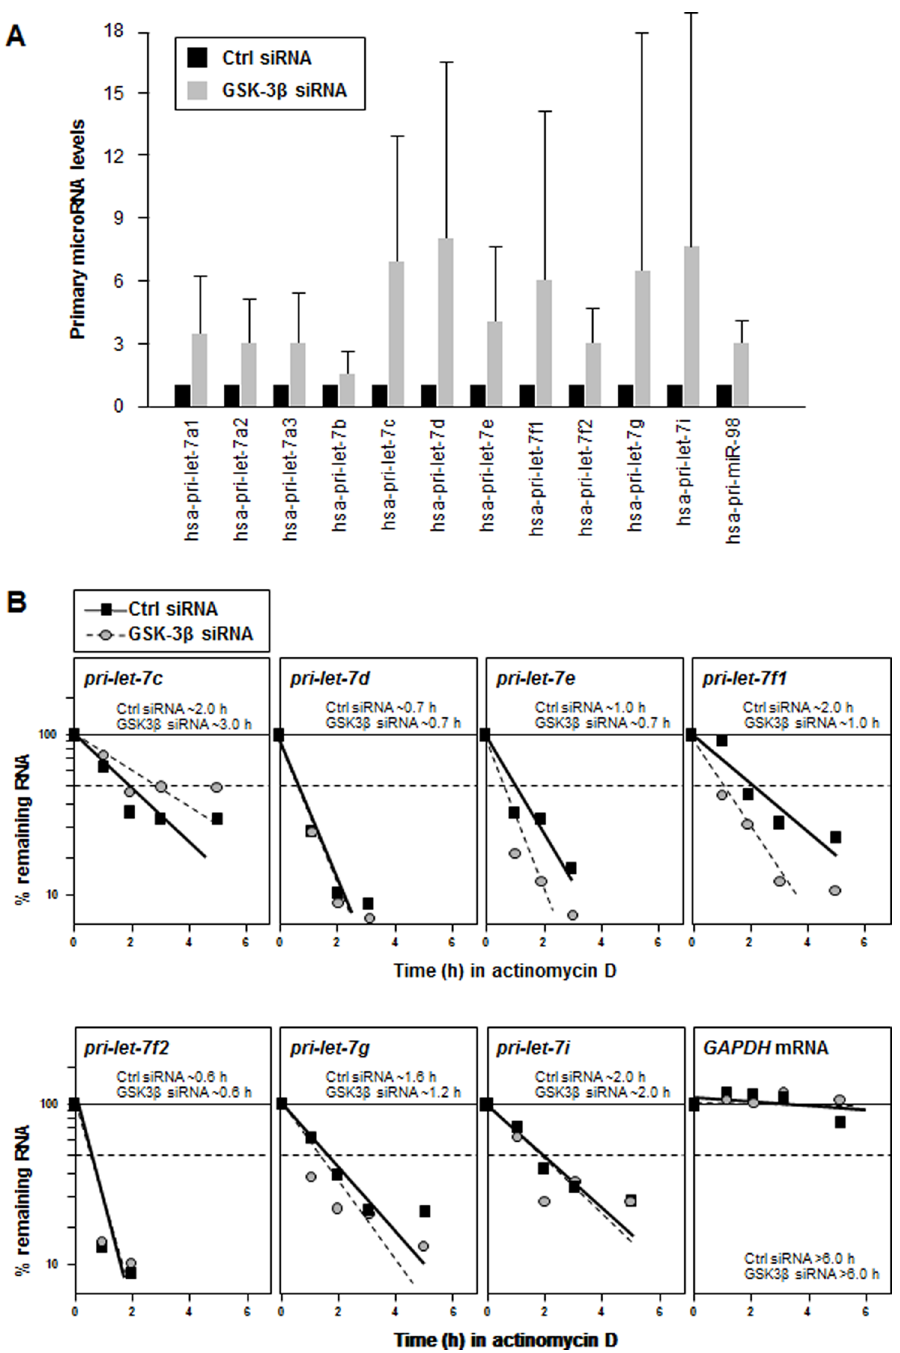
Figure 5. Pri-let-7 levels increase by GSK-3 b silencing mainly via transcriptional upregulation. ( A ) Forty-eight hours after transfecting BG- 1 cells with 100 nM Ctrl siRNA or GSK-3 b siRNA, total RNA was collected and pri-let-7 levels were quantified by RT-qPCR and normalized to 18S rRNA. ( B ) Forty-eight hours after BG-1 cells were transfected as in (A), actinomycin D was added and RNA was collected at the times indicated for RT-qPCR analysis of the levels of pri-let-7 transcripts and GAPDH mRNAs. After normalizing to 18S rRNA levels, the half-life of each RNA was calculated as the time needed to reach 50% of its original abundance. Data are the average of two independent experiments showing similar results.